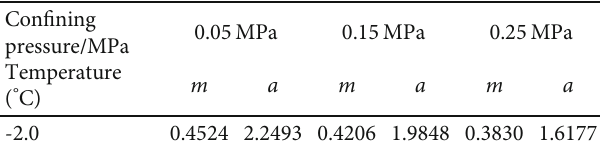
Table 8: Shape parameter and scale parameter solutions (method